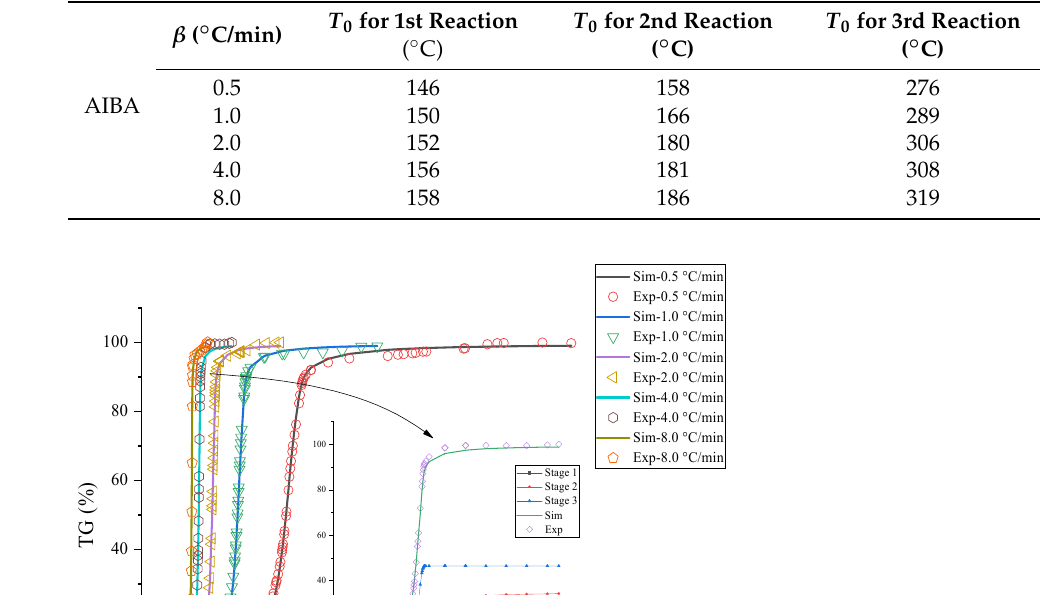
Table 1. Non-isothermal data by TGA tests for 98 mass % AIBA at 0.5, 1.0, 2.0, 4.0, and 8.0 ◦ C /min.